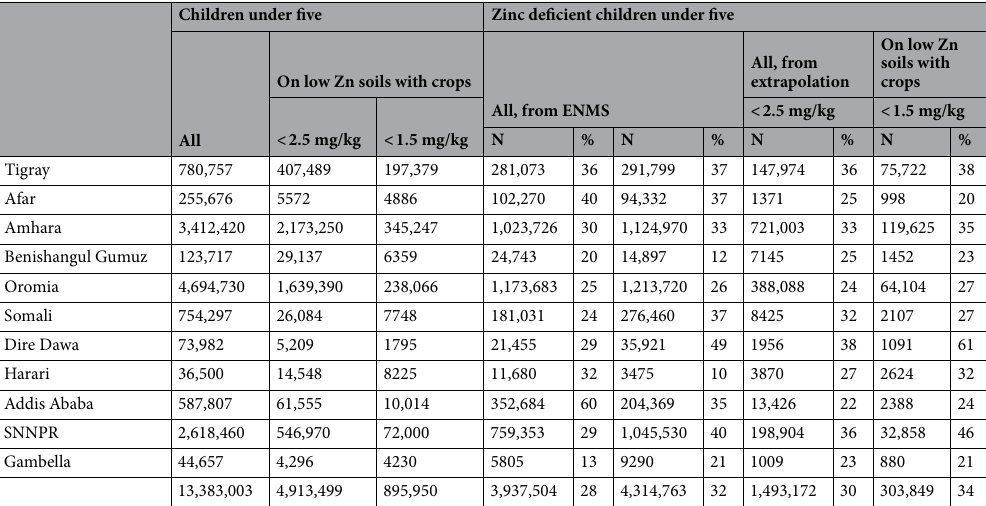
in Amhara (120 k), Tigray (76 k), Oromia (64 k) and SNNPR (33 k).